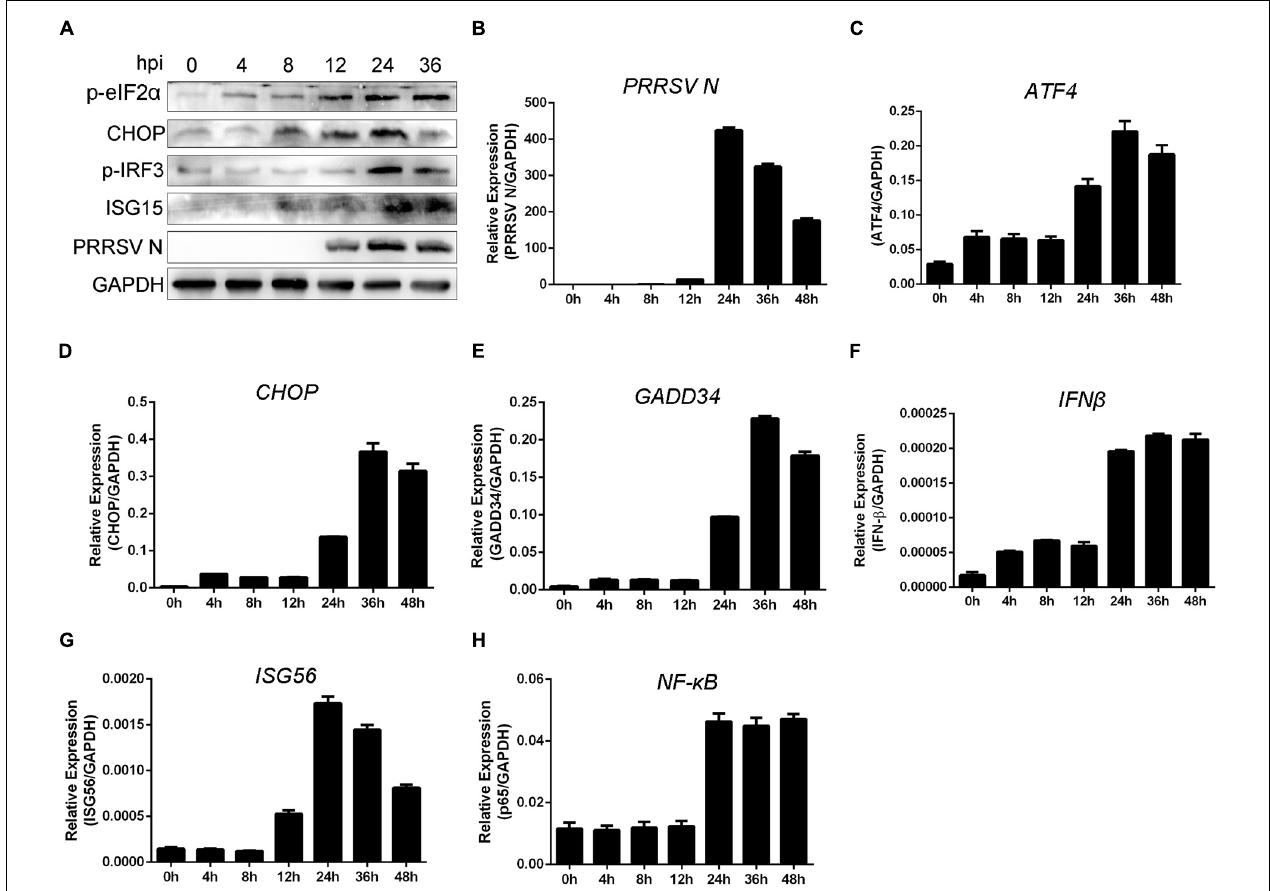
FIGURE 1 | Unfolded protein response is involved in interferon response following PRRSV infection. (A) PAMs were infected with PRRSV (MOI = 1) for the indicated periods (0, 4, 8, 12, 24, and 36 hpi); protein levels of p-eIF2 α , CHOP, p-IRF3, ISG15, and PRRSV N are shown, as detected by Western blot using the indicated antibodies. GAPDH is shown as an internal control. (B–H) Marc-145 cells were infected with PRRSV (MOI = 1) for 0, 4, 8, 12, 24, 36, and 48 h; total cellular RNA was extracted, and qRT-PCR was used to detect the expression of PRRSV N (B) , ATF4 (C) , CHOP (D) , GADD34 (E) , IFN- β (F) , ISG56 (G) , and NF- κ B (H) . Data are representative of the results of three independent experiments (means ±